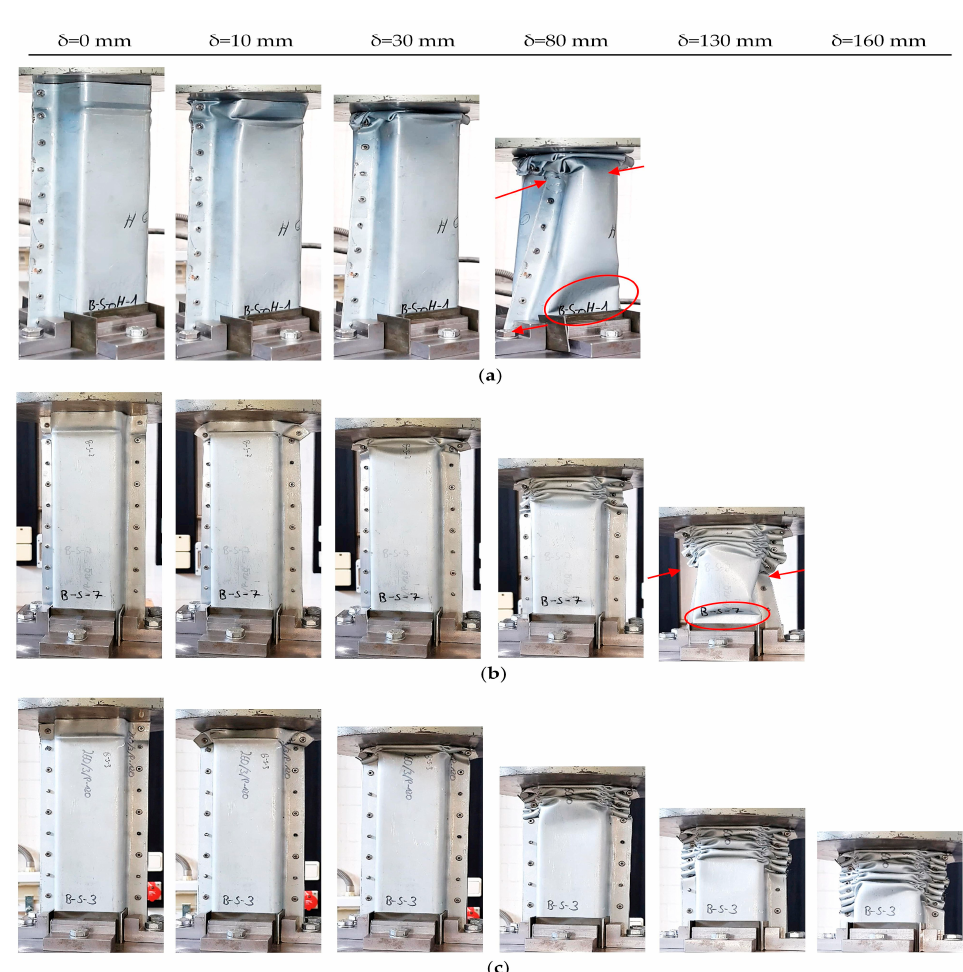
Figure A1. Photographic presentation of the quasi-static collapse progress at different time steps for the double-hat crashboxes ( a ) without, ( b ) with weak and ( c ) with the strong adhesion strength.